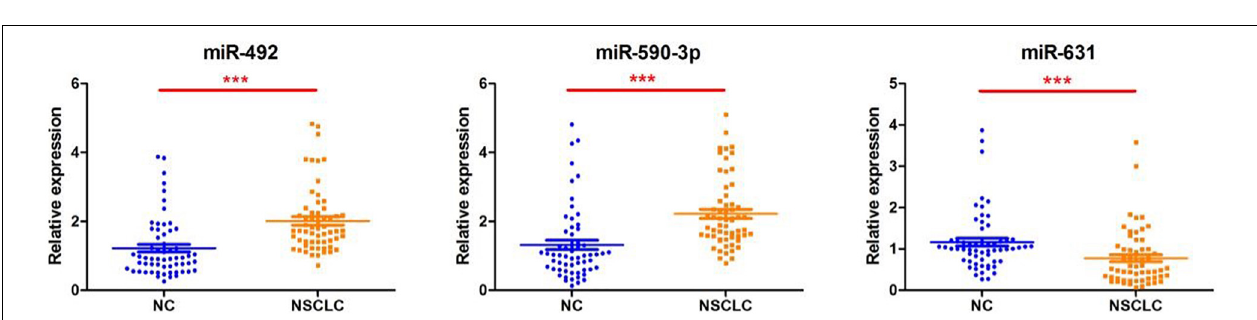
FIGURE 2 | Differentially expressed serum miRNAs in the validation cohort. The miRNA levels of miR-492, miR-590-3p, and miR631 were detected by RT-PCR assay. Data are presented as mean ± SD. *** p < 0.001 vs. NC